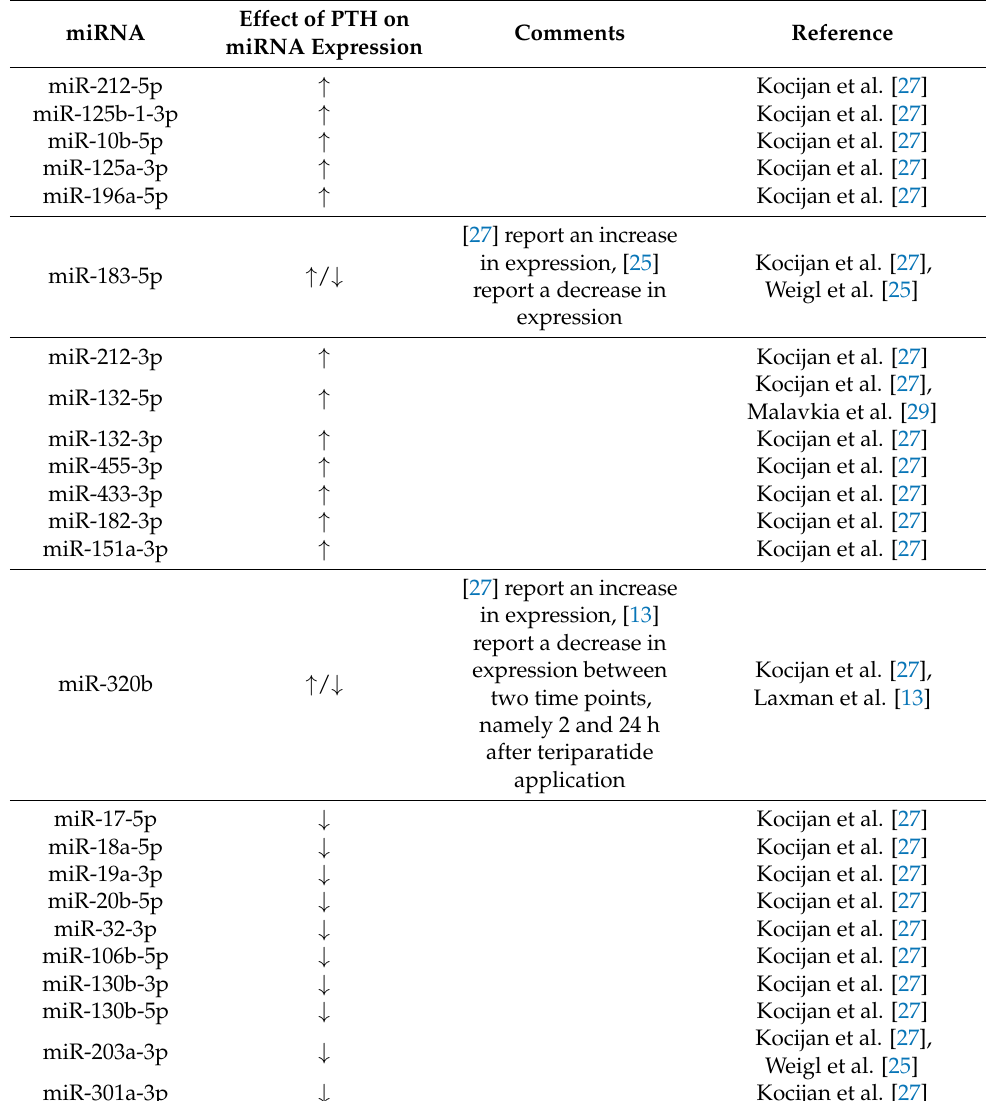
Table 2. MicroRNAs (miRNAs) influenced by